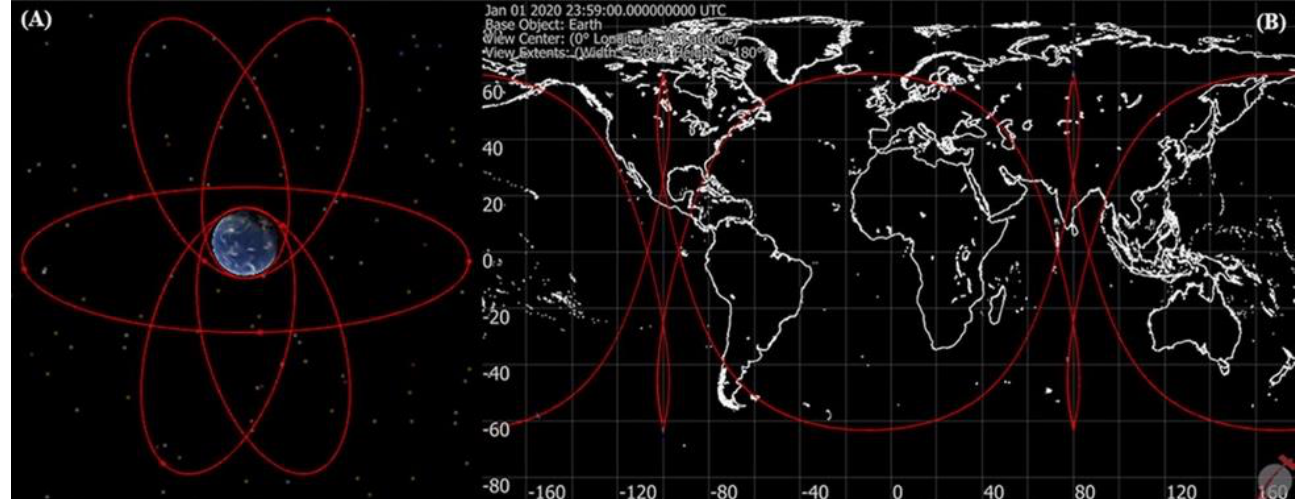
Figure 4. ( A ) The simplest Molniya/GEO constellation to provide continuous global coverage with 2 Molniya over the poles. ( B ) Constellation ground tracks.